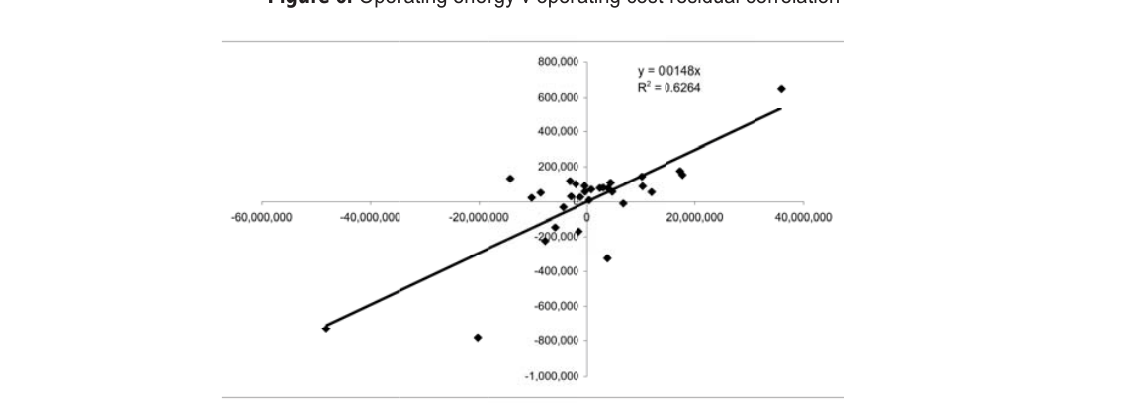
Figure 6: Operating energy v operating cost residual